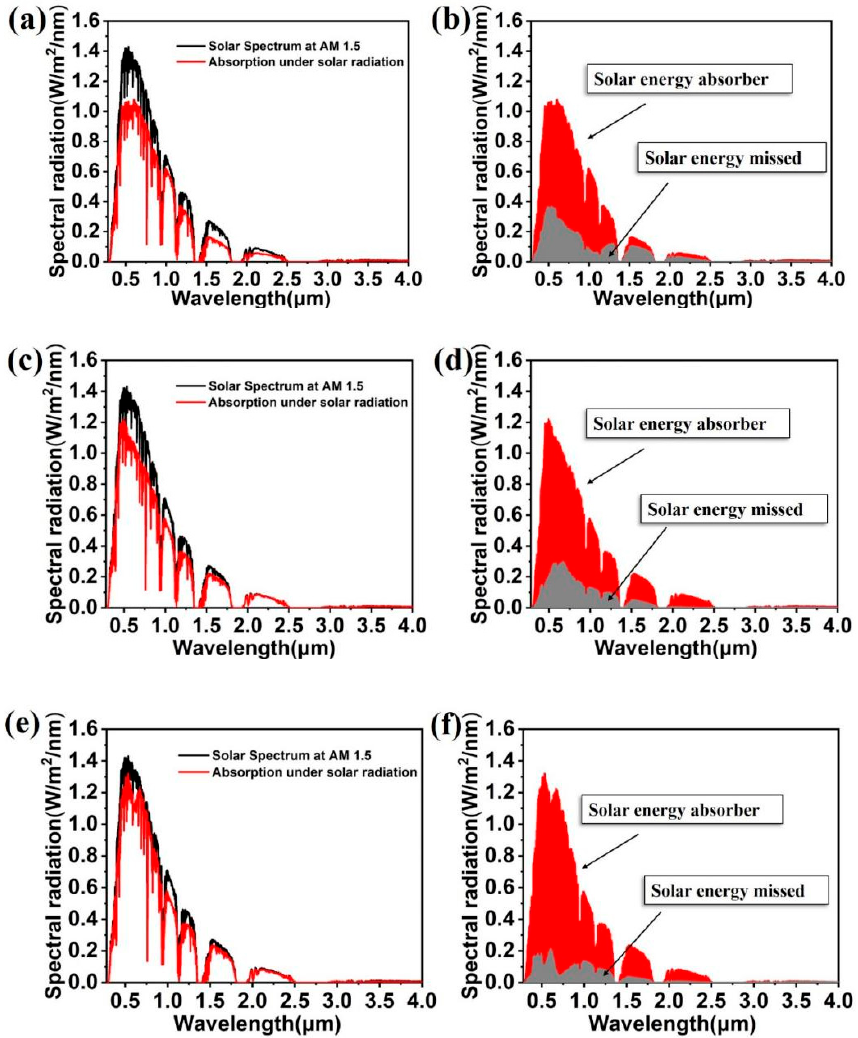
Figure 6. ( a , c , e ) Absorption spectrum of Case 1, Case 2 and Case 3 under AM 1.5 light source, respectively. ( b , d , f ) Corresponding solar energy absorbed and missed in Case 1, Case 2 and Case 3.